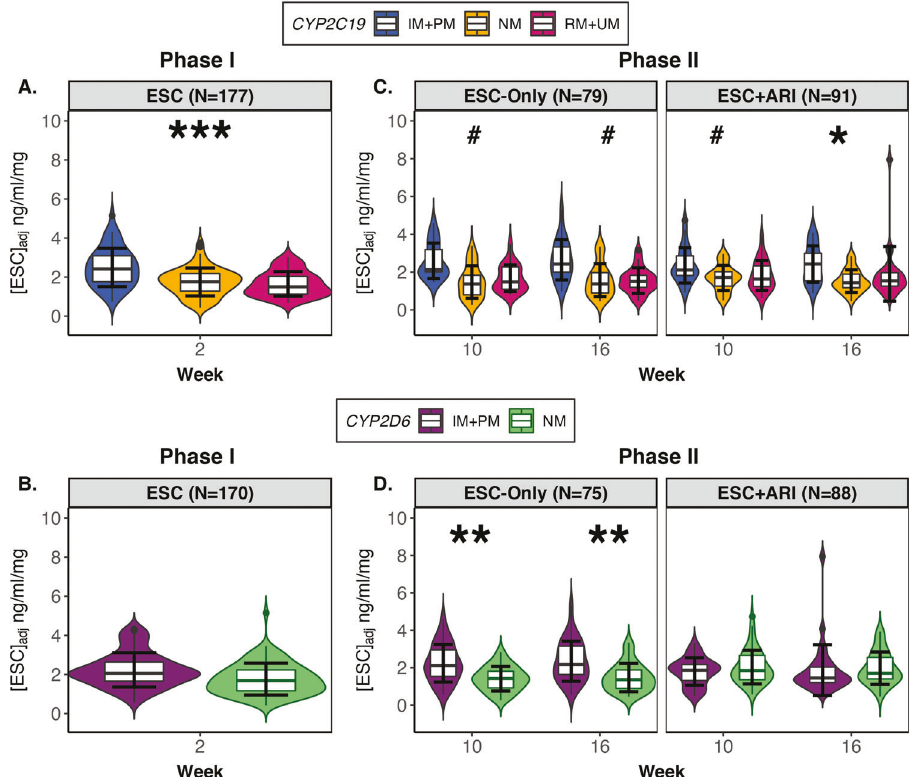
Fig. 4 Dose-adjusted ESC concentrations in serum for Phase I and II by CYP2C19 and CYP2D6 metabolizer groups. During Phase I, A CYP2C19 IM + PMs showed higher mean ESC adj concentrations relative to NMs, whereas there was no signi fi cant difference in ESC adj concentrations between NMs and RM + UMs. B A signi fi cant difference in ESC adj concentrations was not observed between CYP2D6 metabolizer group. During Phase II, for the ESC-Only treatment arm, C CYP2C19 and D CYP2D6 IM + PMs compared to NMs had higher ESC levels in serum. In the ESC + ARI treatment arm, ESC adj serum levels were associated with only C CYP2C19 , but not D CYP2D6 , with higher ESC adj concentrations in CYP2C19 IM + PMs relative to NMs. All linear regression analyses were adjusted for age, ancestry, sex, recruitment site, time since last dose, CYP2C19 and CYP2D6 metabolizer groups. Error bars represent standard error. ARI aripiprazole, ESC escitalopram,